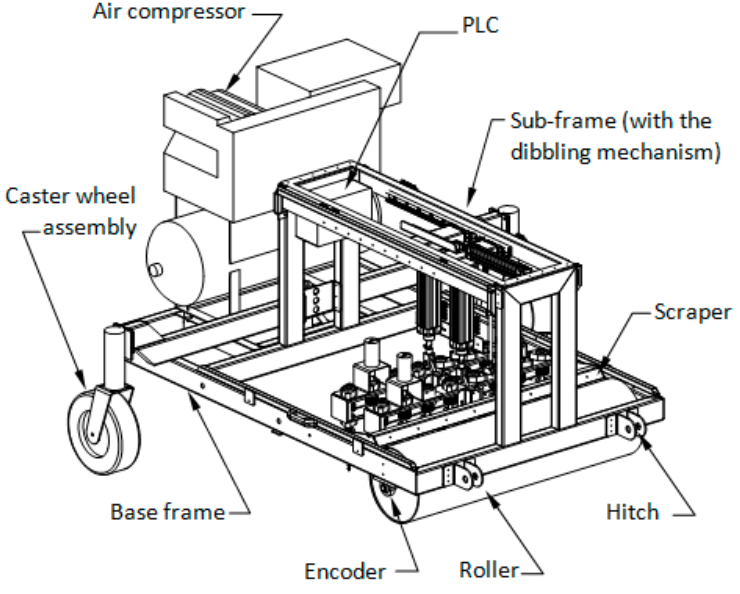
Figure 6. The dibbler components.